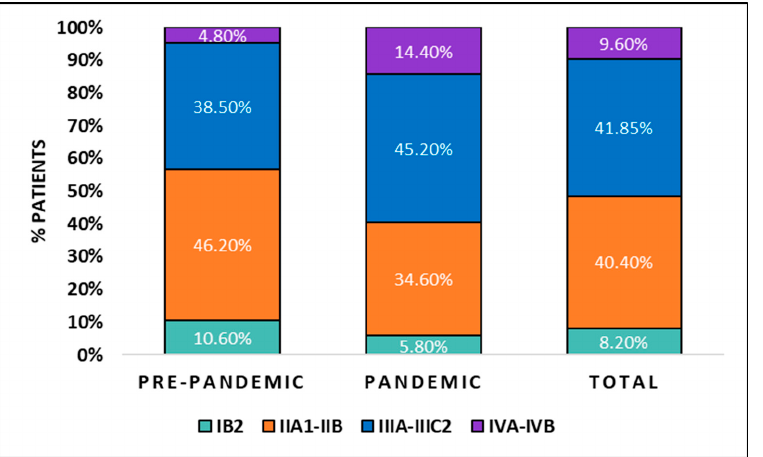
Figure 1. Graphical comparison of patients with radiotherapy-necessitating cervical cancer (IB2- IVB) before and during the COVID-19 pandemic. Cervical cancer staging is reported by International Federation of Gynecology and Obstetrics (FIGO) staging